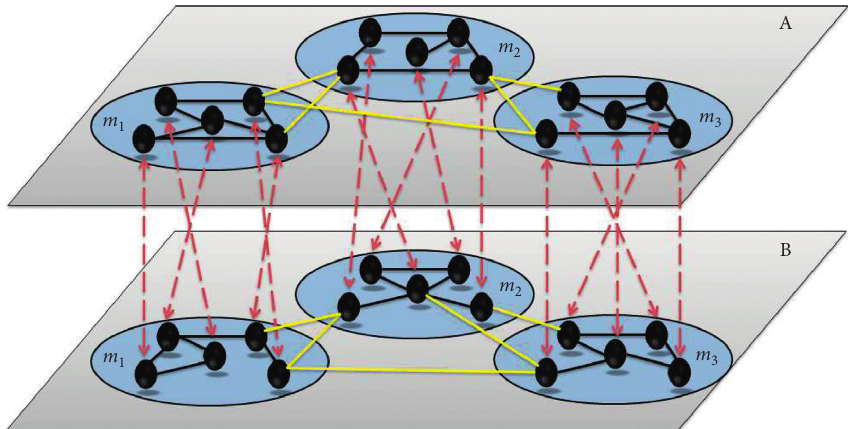
Figure 1: The schematic diagram of interdependent community networks. The ICNs are constructed by coupling two networks with the same community structures and the same average degree. Each node belongs to exactly one community and has two types of connectivity links: intracommunity links (black solid lines) and intercommunity links (yellow solid lines). The dependency links (red-dotted lines) are restricted to only connecting nodes within the same community among networks. For example, a node in the community m 1 of subnetwork A only depends on a node in the same community m 1 of subnetwork B. Furthermore, the dependency relation between networks implies the influence of failure for a pair of interdependent nodes: if one fails, the other fails